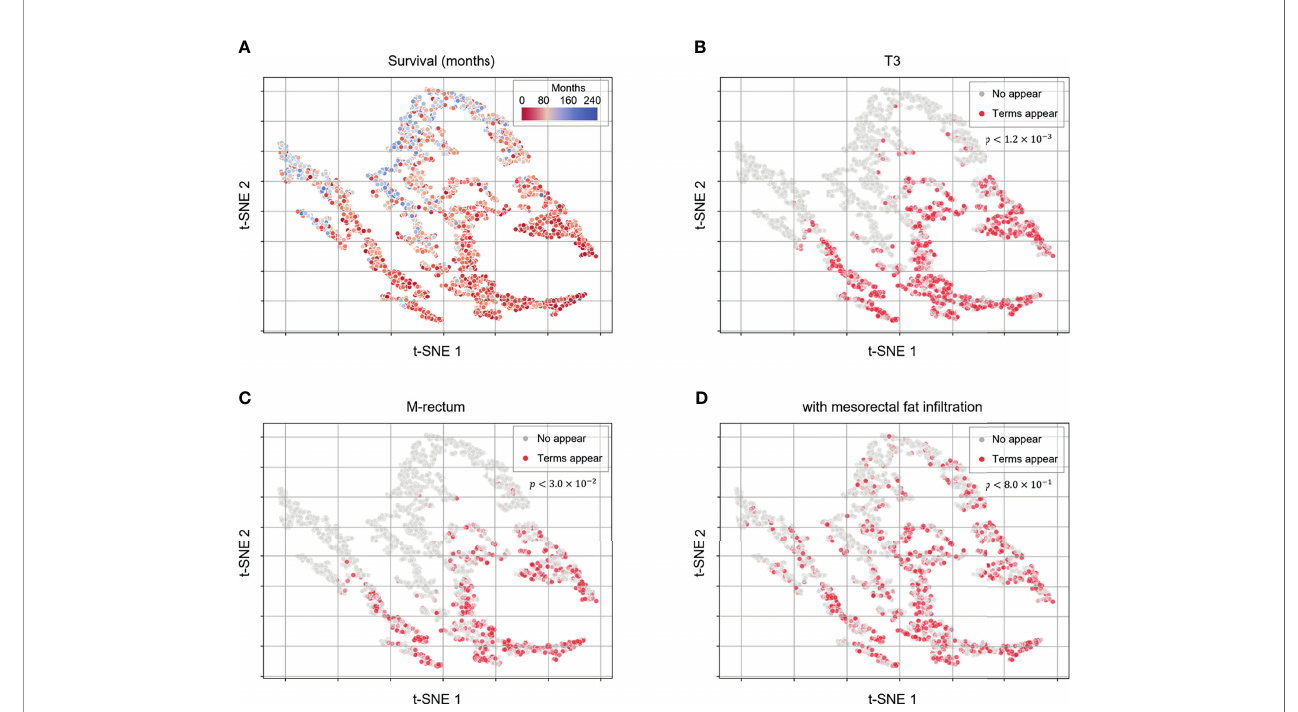
FIGURE 3 | Patient embedding vector scatter plot of the survival and high-risk features. The patient embedding vectors were obtained from the RNN of the deep- transfer-learning model and visualized in a two-dimensional scatter plot using t-distributed stochastic neighbor embedding. (A) The survival of each patient is depicted in red (worse survival) or blue (better survival). (B – D) The color represents whether clinically meaningful terms (high-risk features: T3, (B) ; mesorectal fat in fi ltration, (C) ; Rb, (D) appear (red) in a patient ’ s radiological report or not (gray). p -values were calculated using the log-rank test to compare the survival between patient groups strati fi ed by appearance of the